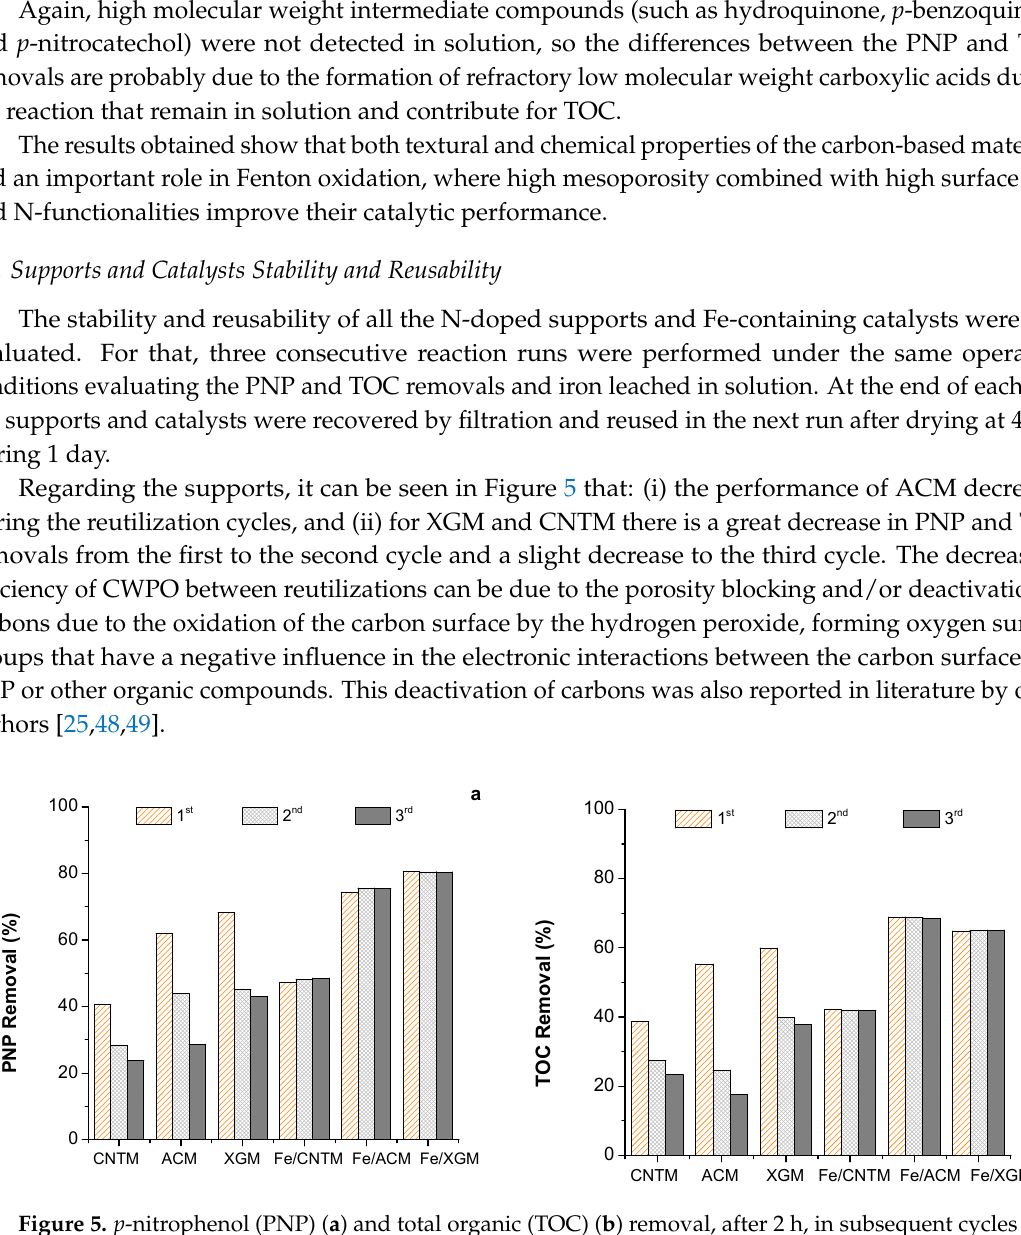
Figure 5. p -nitrophenol (PNP) ( a ) and total organic (TOC) ( b ) removal, after 2 h, in subsequent cycles during wet peroxidation and adsorption with the carbon supports or Fenton’s reaction and adsorption with the iron-containing catalysts (pH = 3.0, T = 30 ◦ C, [support] = 0.25 g L − 1 , [H 2 O 2 ] = 29 mmol L − 1 , [PNP] = 3.6 mmol L − 1 and H 2 O 2 :PNP molar ratio = 8.1).